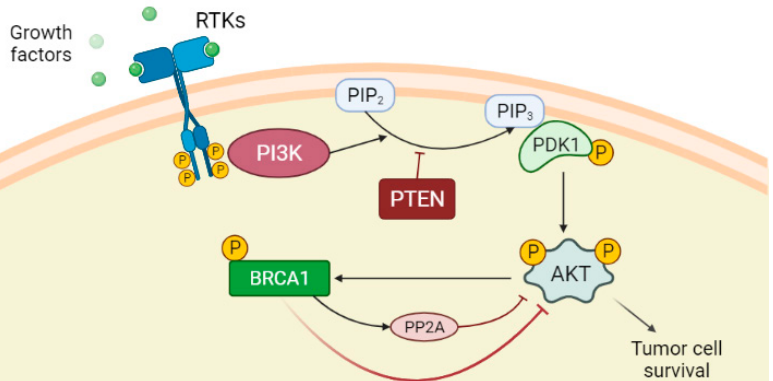
Figure 1. PI3K/AKT pathway is an intracellular signal transduction pathway that promotes cell growth and proliferation in response to extracellular signals. The binding of the ligands such as growth factors to the receptor tyrosine kinases (RTKs) induces dimerization of two RTK monomers, which consequently leads to activation of the intracellular tyrosine kinase domain and auto-phos- phorylation by each monomer. The phosphatidylinositol 3-kinase (PI3K), once activated through direct stimulation of the regulatory subunit bound to the activated receptor, converts phosphatidyl- inositol 4,5-bisphosphate (PIP2) into phosphatidylinositol 3,4,5-triphosphate (PIP3). PIP3 binds the 3-phosphoinositide-dependent protein kinase-1 (PDK1) at the plasma membrane. PDK1 in turn phosphorylates and activates AKT protein. Once activated, AKT via phosphorylation regulates ac- tivation or suppression of several proteins involved in cell growth and proliferation. Phosphatase and tensin homolog (PTEN) is the main downregulation protein that can convert PIP3 into PIP2. Although AKT activation promotes BRCA1 expression through phosphorylation, BRCA1 can downregulate AKT activation by different mechanisms, among which are the activation of protein phosphatase 2A (PP2A), which dephosphorylates AKT.